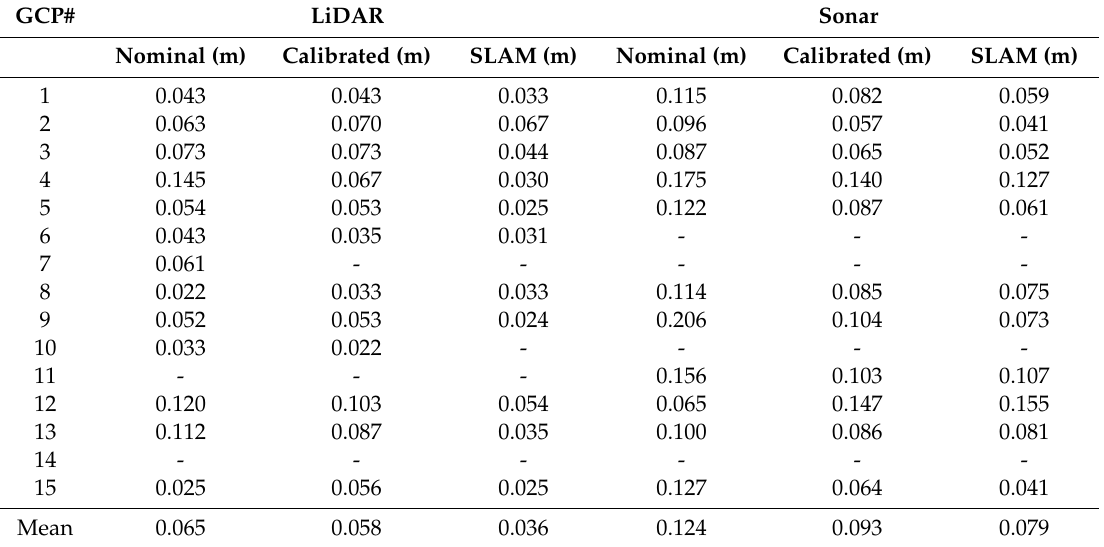
Table 2. Consistency of LiDAR control points expressed as root-mean-square (RMS) distance from the mean of each set of matched control